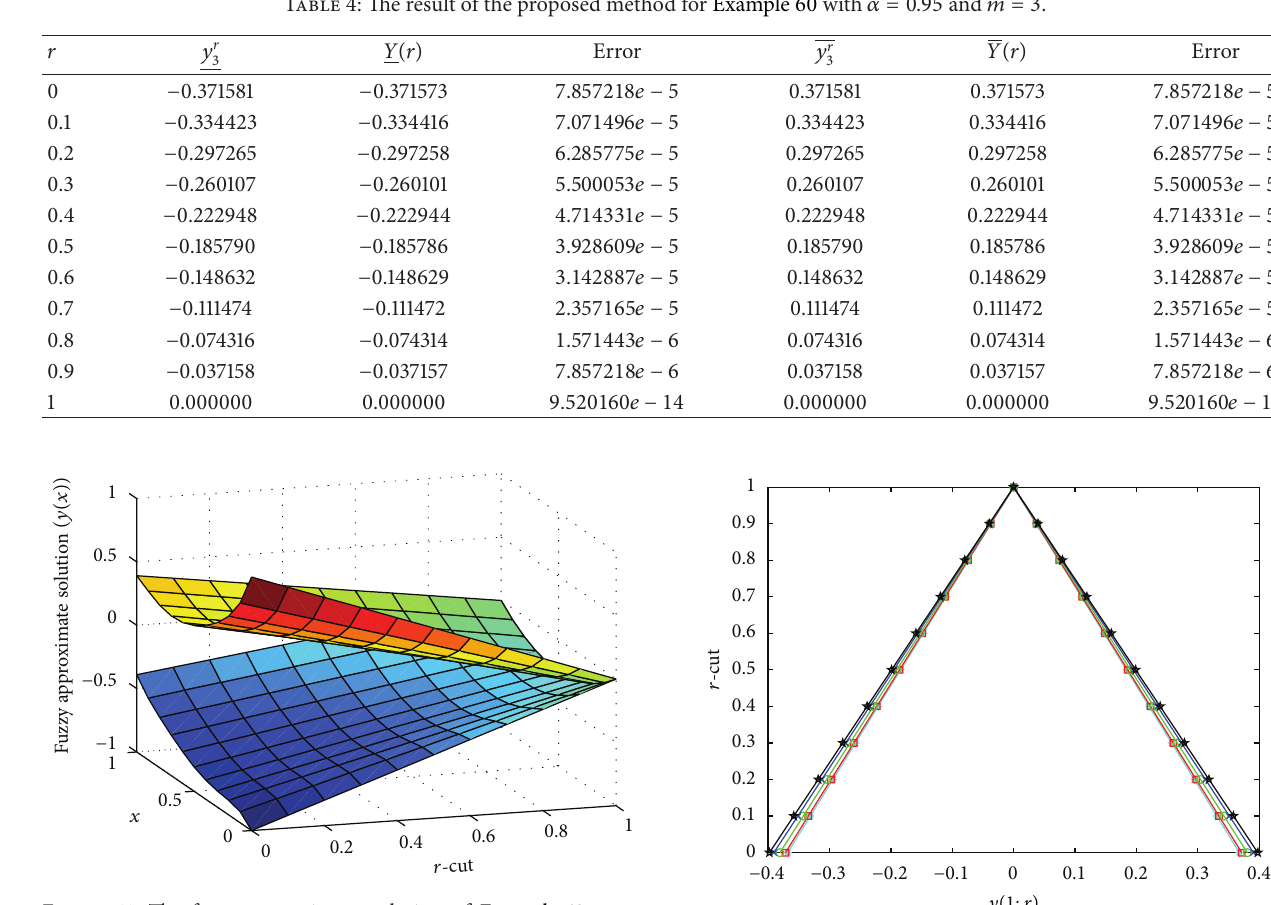
Figure 11: The fuzzy approximate solution of Example 60, 𝛼 = 0.75, 𝑚 = 5 .